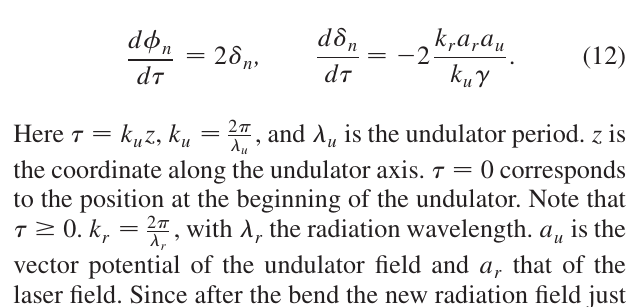
FIG. 8. (Color) Beam optical functions for the first order iso- chronous bend.